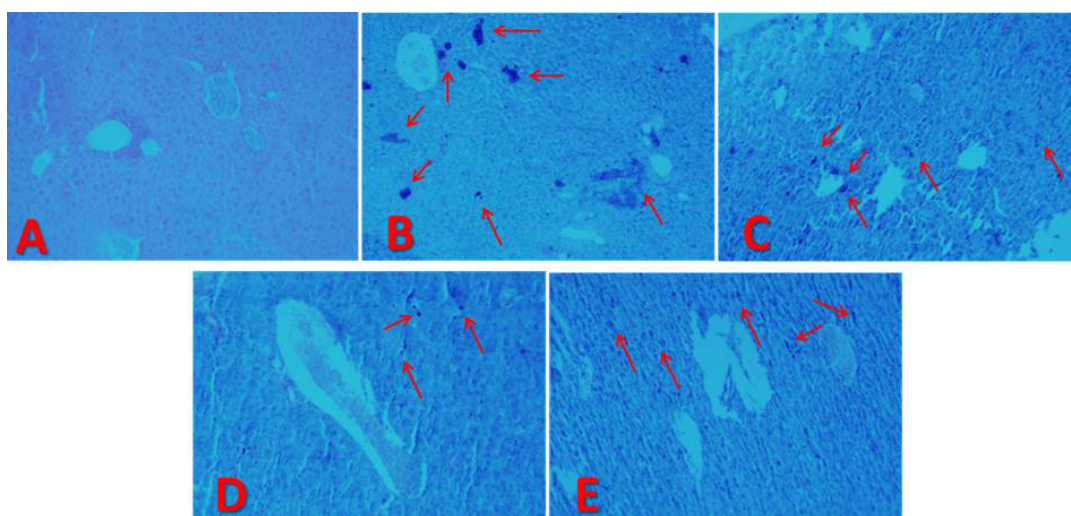
FIGURE 5 - Perls’ Prussian blue staining of liver tissues (40x magnification). A: control, B: liver tissues of iron-overloaded mice, C: liver tissues of iron-overloaded mice treated with DFO, D: liver tissues of iron-overloaded mice treated with 30 mg/kg/day of naringin, and E: liver tissues of iron-overloaded mice treated with 60 mg/kg/day of